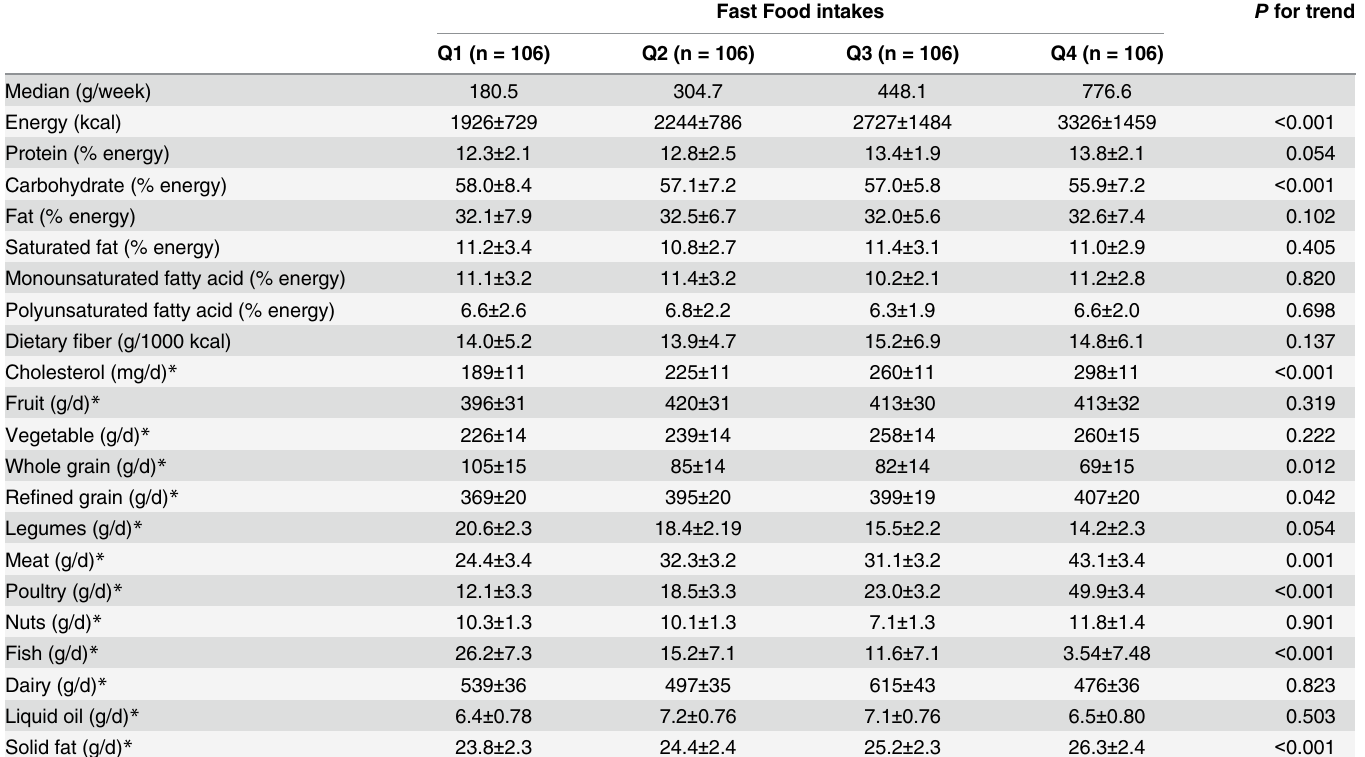
Table 2. Dietary intakes according to quartiles of fast food intake among children and adolescents at baseline: Tehran Lipid and Glucose Study. Fast Food